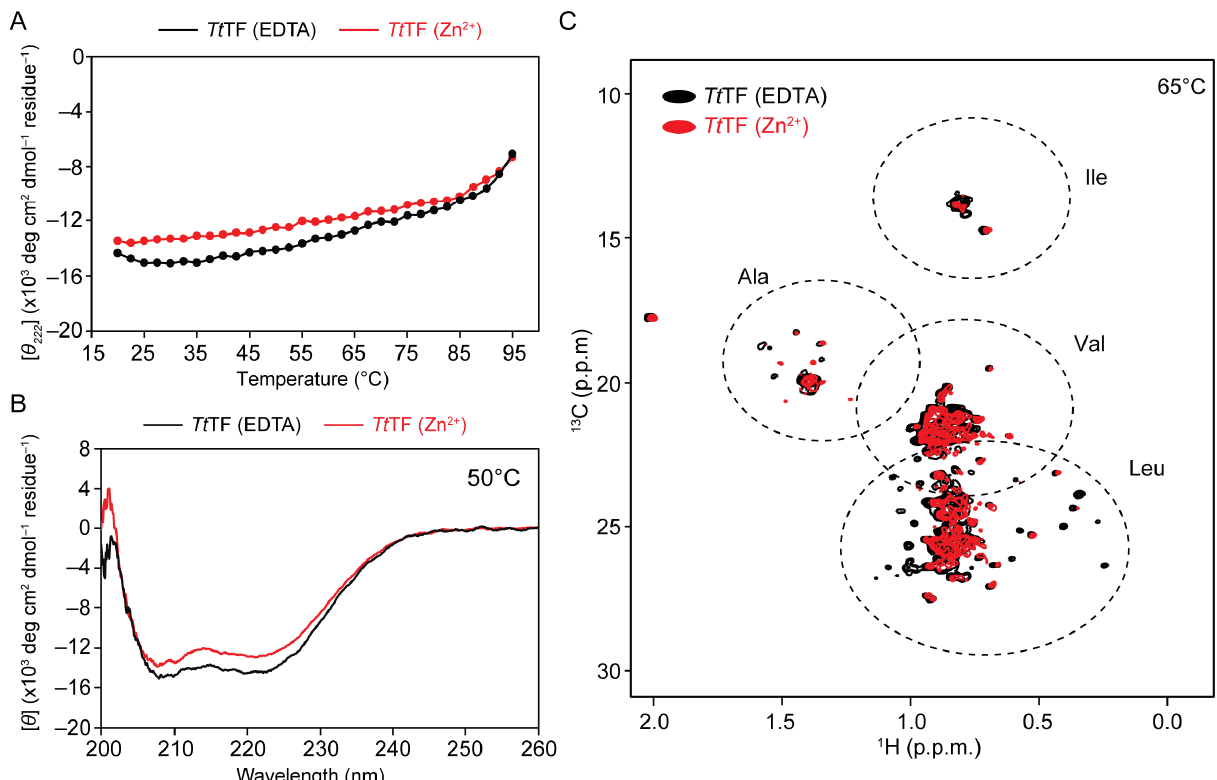
Figure 3. Structural characterization of Tt TF in the absence and presence of Zn 2+ . ( A ) Temperature scan of CD ellipticity at 222 nm performed from 20 ◦ C to 95 ◦ C. The plots for Tt TF (Zn 2+ ) and Tt TF (EDTA) are shown in red and black, respectively. ( B ) CD spectra of Tt TF (Zn 2+ ) (red) and Tt TF (EDTA) (black) at 50 ◦ C. ( C ) The HMQC spectra of [U- 15 N; Ala- 13 CH 3 ; Met- 13 CH 3 ; Ile- δ 1- 13 CH 3 ; Leu/Val- 13 CH 3 / 13 CH 3 ]-labeled Tt TF (Zn 2+ ) (red) and Tt TF (EDTA) (black). Typical regions for the methyl resonances from Ala, Ile δ 1, Val, and Lue are indicated by Dashed eclipses. The NMR experiments were performed at 65 ◦